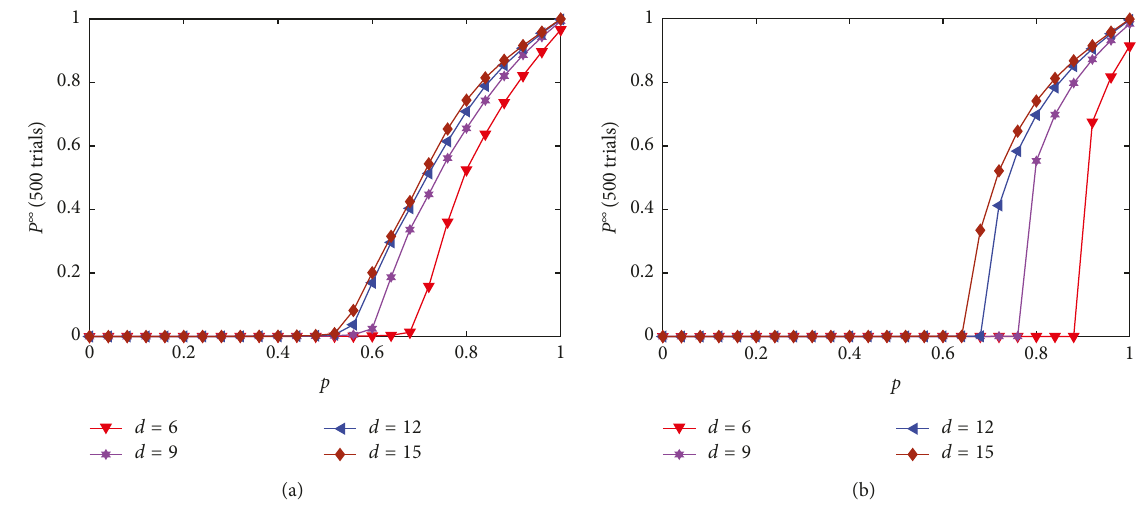
Figure 10: Impacts of degree on the robustness of a tripartite network subject to node attacks to every partite set. The network con- figurations are n i � n j � 4 × 10 4 and p i � p j � d /2 n i . (a) Robustness of the tripartite network based on the network model M1. (b) Robustness of the tripartite network based on the network model